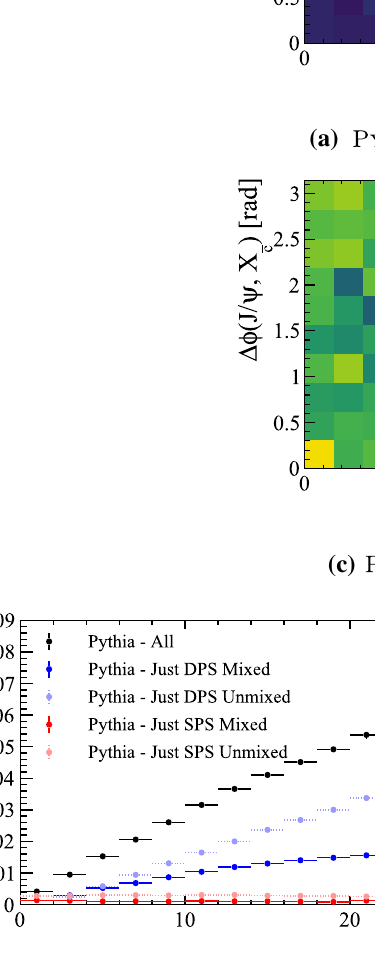
Fig. 22 Ratio of differential cross-section of ϒ( 1 S ) X b X and B + hadrons as a function of (left) the number of parton interactions in a collision b and (right) the number of charged particles within the pseudo-rapidity region 2 . 0 < η < 4 . 5, as generated with Pythia